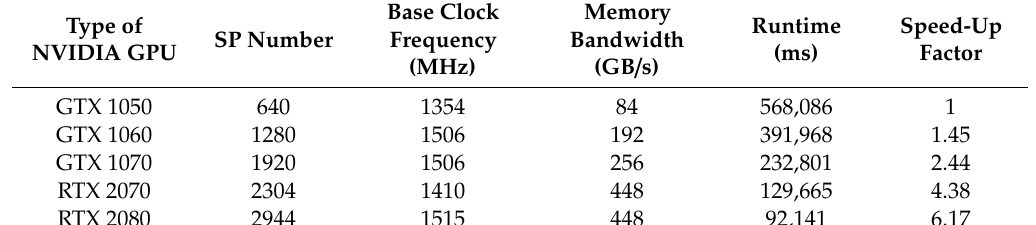
Table 3. Performance comparison for di ff erent types of graphics processing unit (GPU).